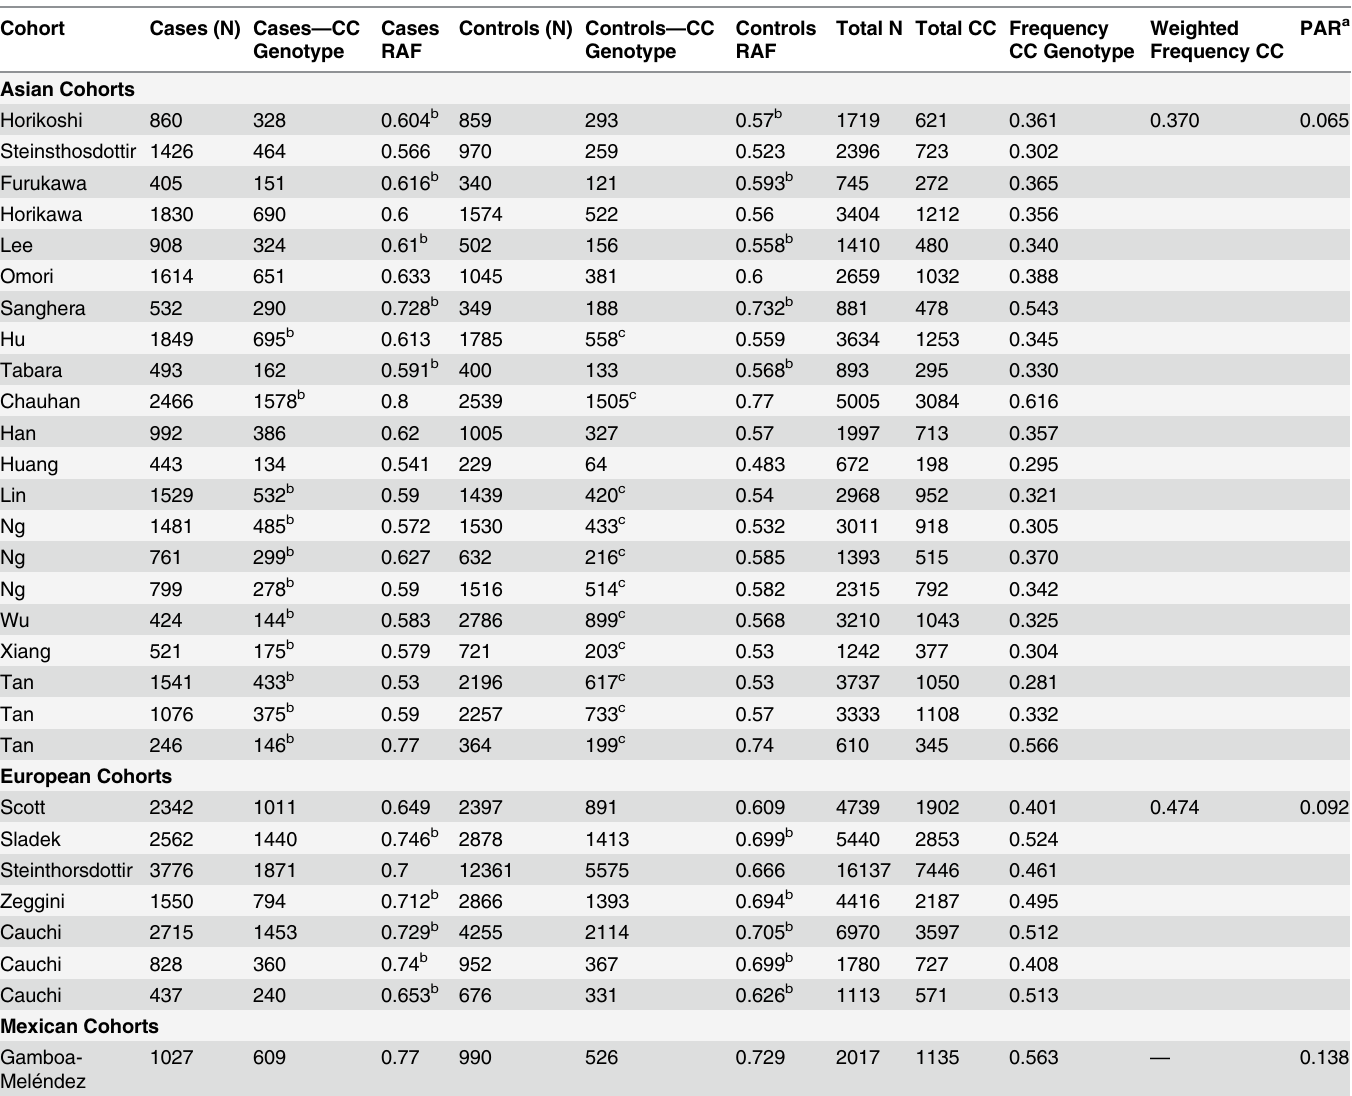
Table 1. CC genotype frequencies for T2DM cases and controls, with calculated population attributable risks.